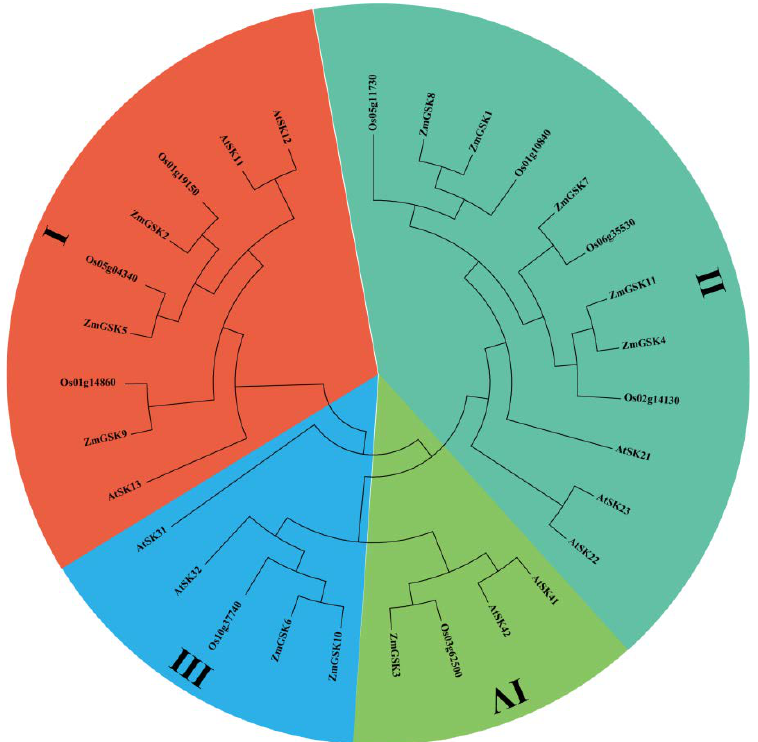
Figure 1. Phylogenetic-analysis results of GSK-3 proteins in Arabidopsis, rice, and maize. The phylogenetic tree was constructed using MEGA7 and the maximum likelihood method with 1000 bootstraps. Different clades of the GSK family are marked with different colors.